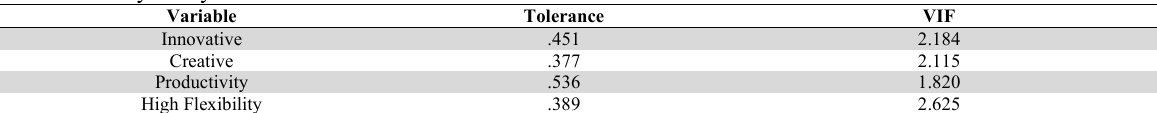
Multicollinearity Analysis